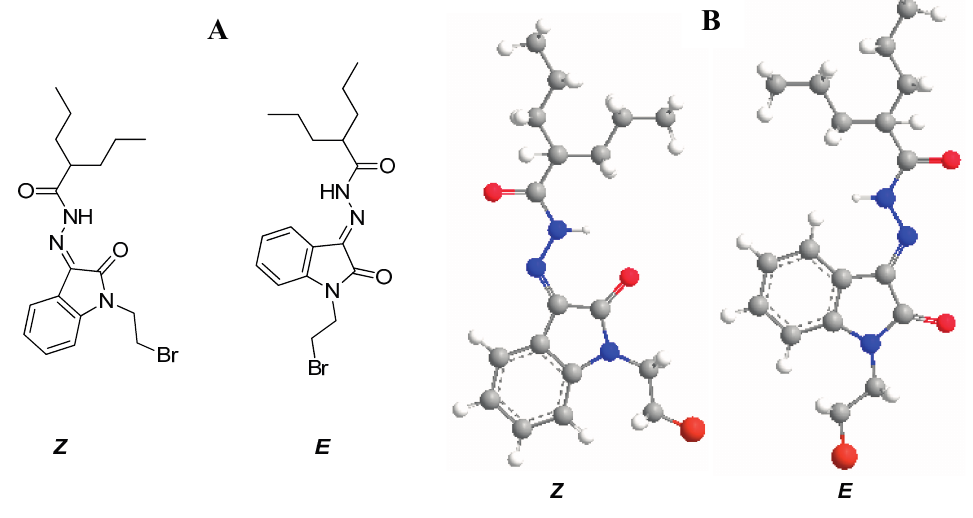
Figure 2. ( A ) The expected geometrical isomers, Z and E forms, of N ′ -(1-(2-bromoethyl)-2- oxoindolin-3-ylidene)-2-propylpentane hydrazide; ( B ) The expected geometrical isomers, the 3D structure of Z and E forms, of N ′ -(1-(2-bromoethyl)-2-oxoindolin-3-ylidene)-2-propyl pentane